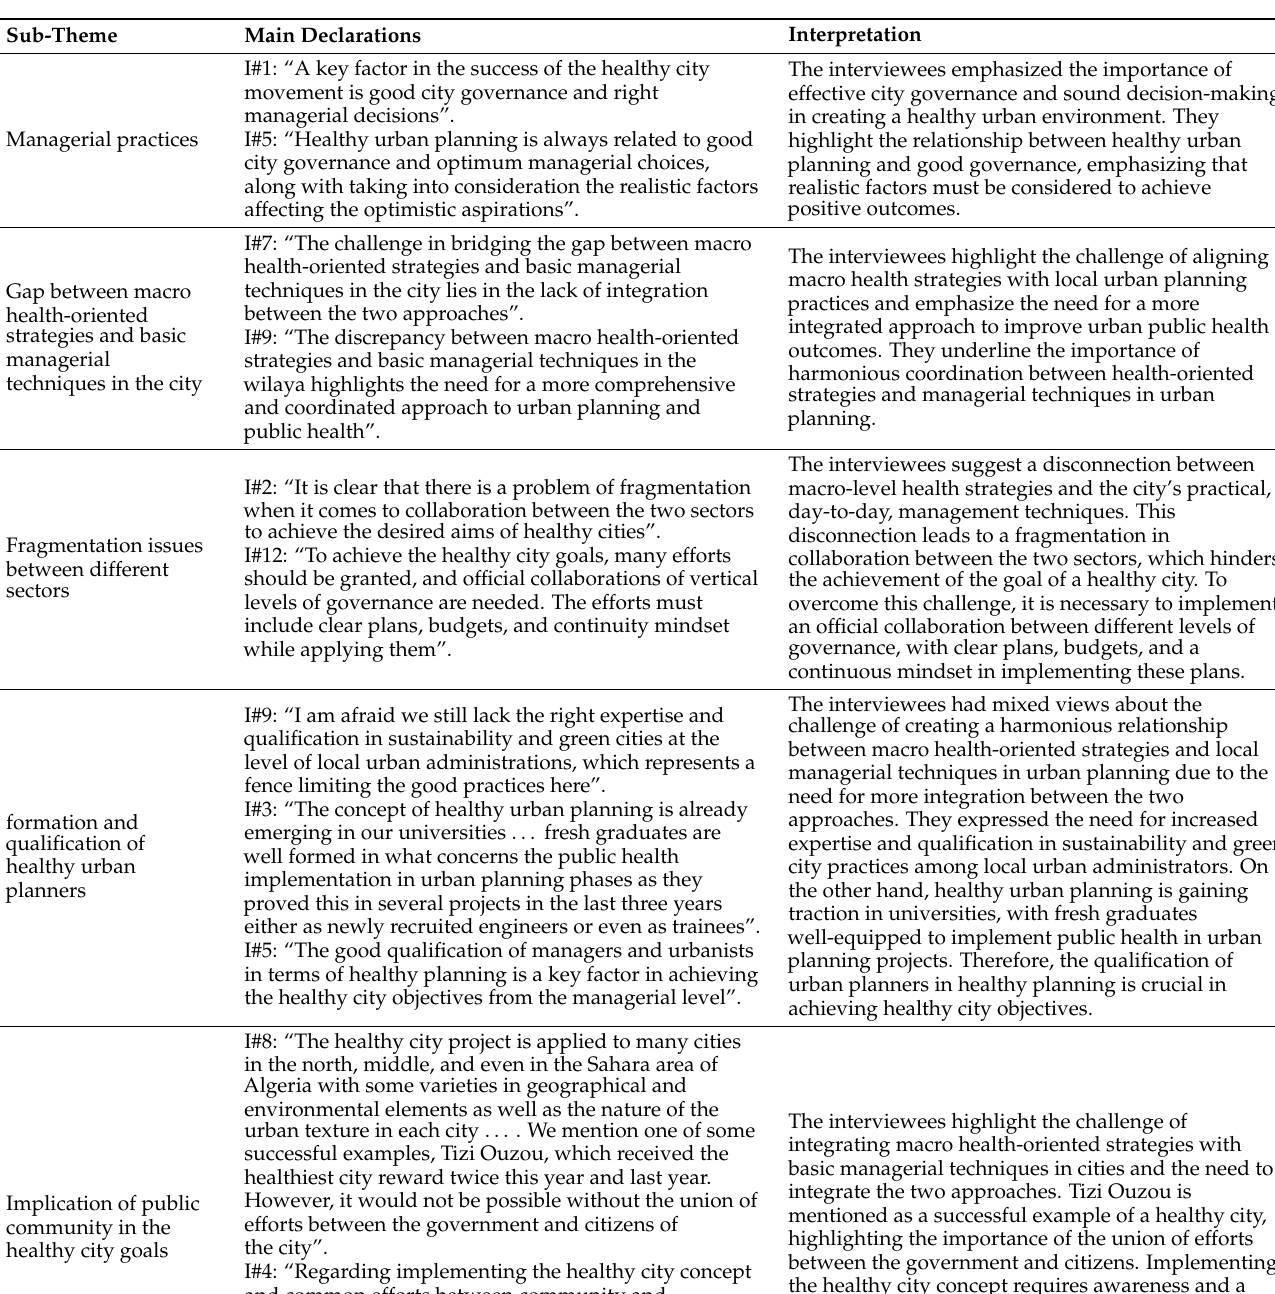
Table 2. Theme 2: management, governance, and leadership skills for the identification of the healthy city concept—results and